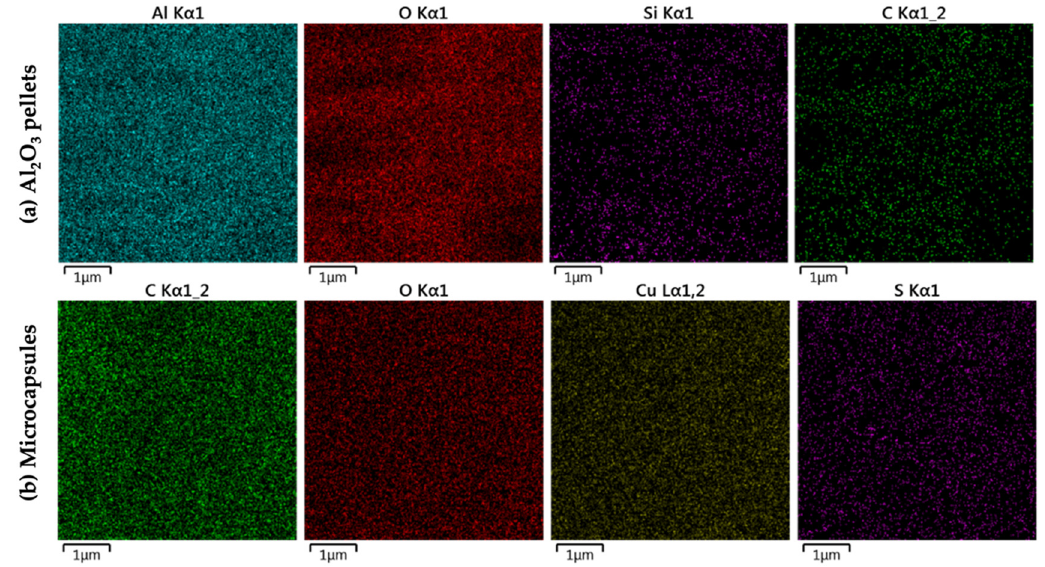
Figure 6. EDS analysis. Distribution of elements for ( a ) Laccase ‐ Al 2 O 3 pellets, where aluminum, Oxygen, silicon, and carbon channels are shown; and ( b ) Laccase ‐ alginate microcapsules, where carbon, oxygen, sopper and sulfur channels are shown.